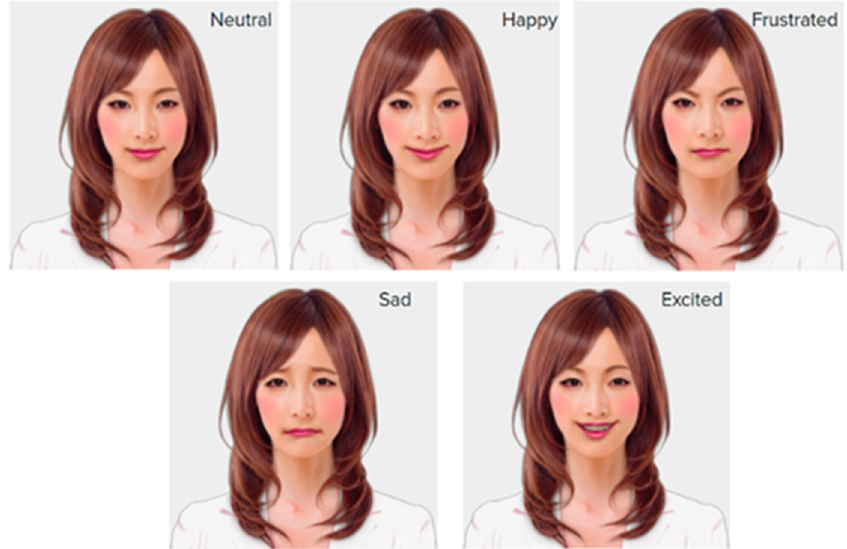
Figure 1. Facial Expressions [46].